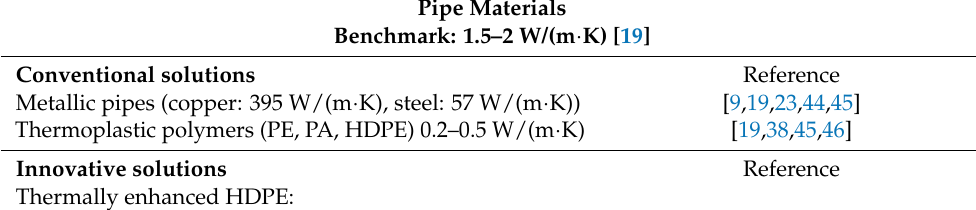
Table 1. Common pipe materials in GCHP systems with corresponding thermal conductivities. Pipe